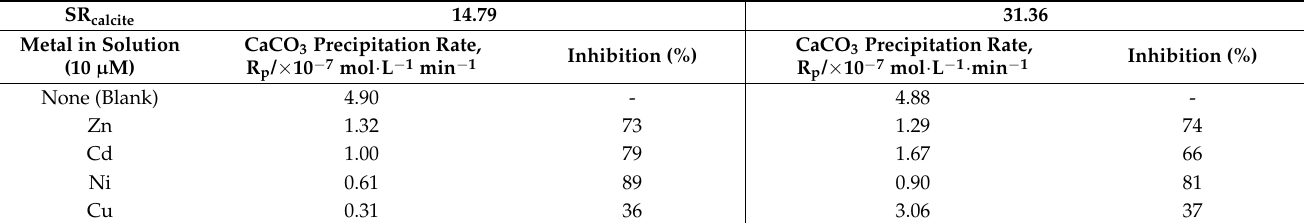
Table 7. Precipitation of calcium carbonate in supersaturated solutions in the presence of 10 μ M of Zn, Cd, Ni and Cu. A total of 20 mL of active A. obliquus culture with modified culture medium and illumination, were included in the supersaturated solutions. Supersaturation ratio with respect to calcite, precipitation rate of calcium carbonate and % inhibition (with reference to the blank); 25 °C, pH 8.50, 0.15 M of NaCl.